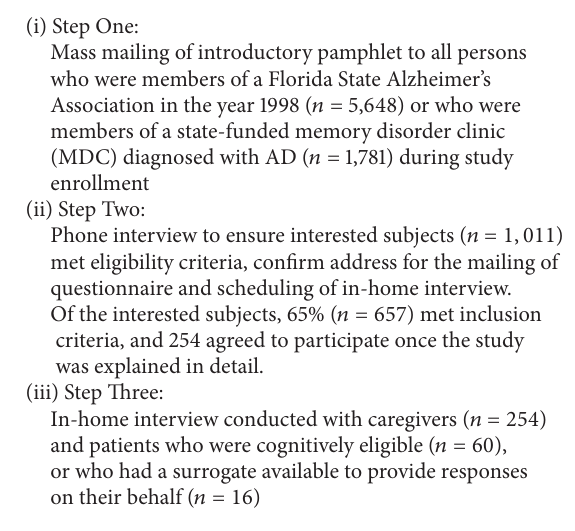
Figure 1: A Risk Vulnerability Model of Elder